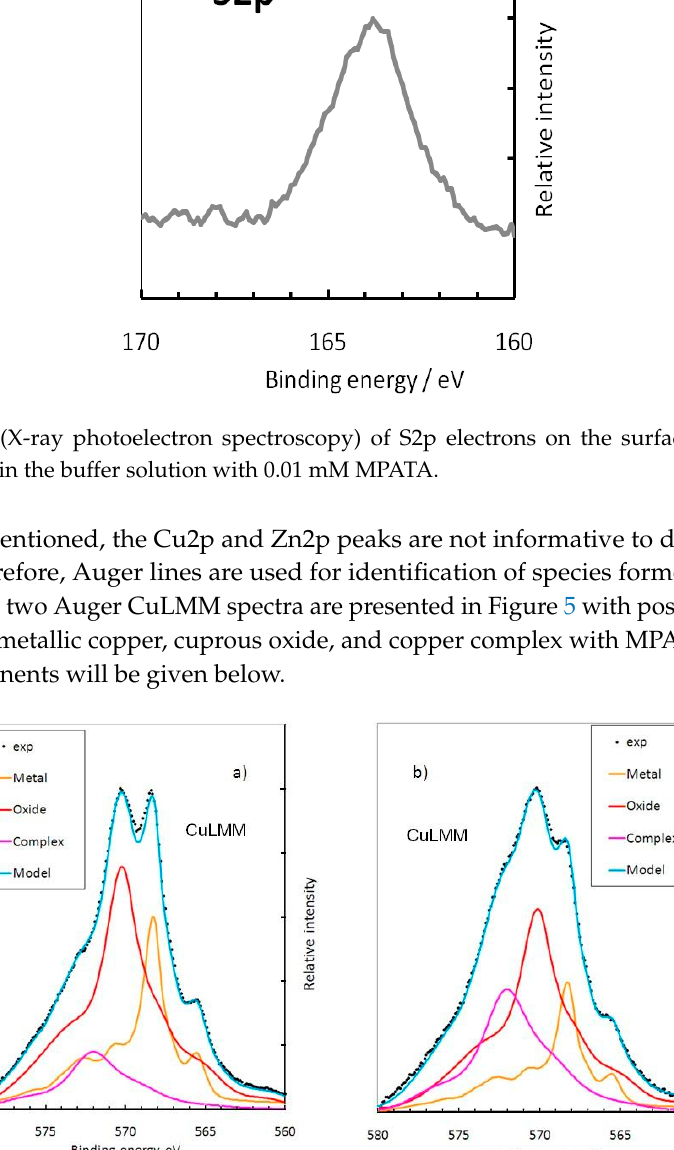
Figure 5. Deconvolution of the Auger CuLMM spectra into individual components for samples exposed in 0.01 mM MPATA solution: ( a ) 1 min; ( b ) 17 h.